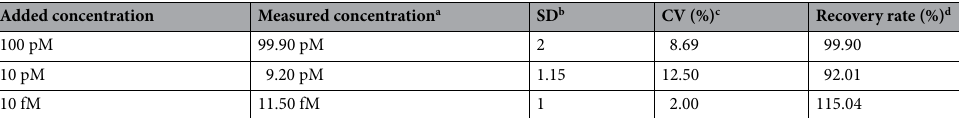
Table 1. Recovery test for synthetic 59-mer target DNA spiked into diluted human serum. a Mean of three measurements. b Standard deviation of three measurements. c Coefficient of variation = SD/mean × 100. d Measured value/added value ×